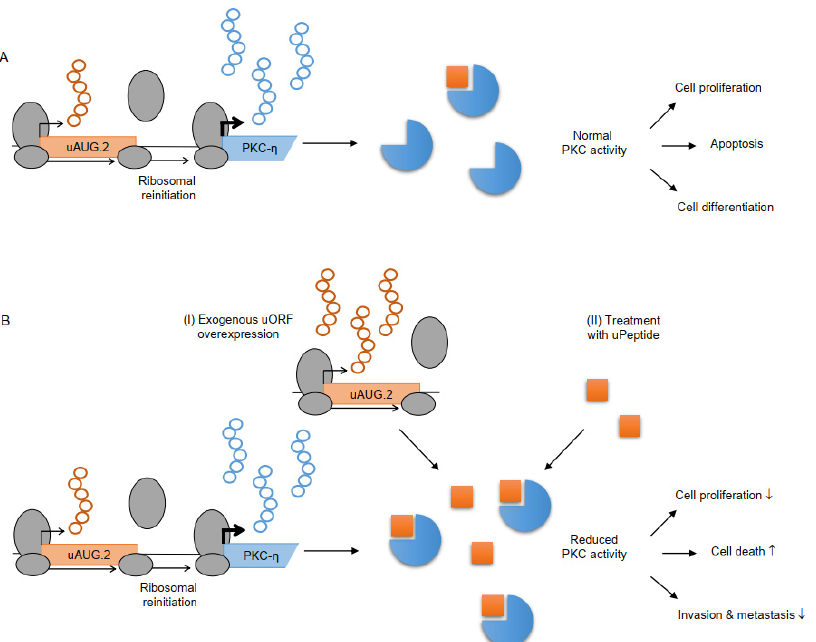
Figure 4. Effects of PKC- η uAUG.2 on protein kinase activity and downstream function [125]. ( A ) The uAUG.2 peptide (orange square) encoded from the PKC- η TLS inhibits the catalytic activity of novel PKCs (blue circles). ( B ) Increased uPeptide levels can lead to reduced PKC activity, resulting in decreased ( ↓ ) cell proliferation, invasion and metastasis and increased ( ↑ ) cell death. Overexpression of uAUG.2 (I) or direct application of the AUG.2 uPeptide as a small peptide drug (II) may offer novel ways of protein kinase-inhibition in cancer therapy.